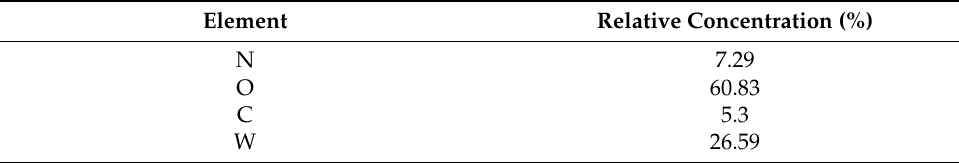
Figure 5. High-resolution spectra; ( a ) C1s core level, ( b ) O1s core level and ( c ) W4f core level. Table 1. Relative concentrations of the elements revealed at the WO x surface.